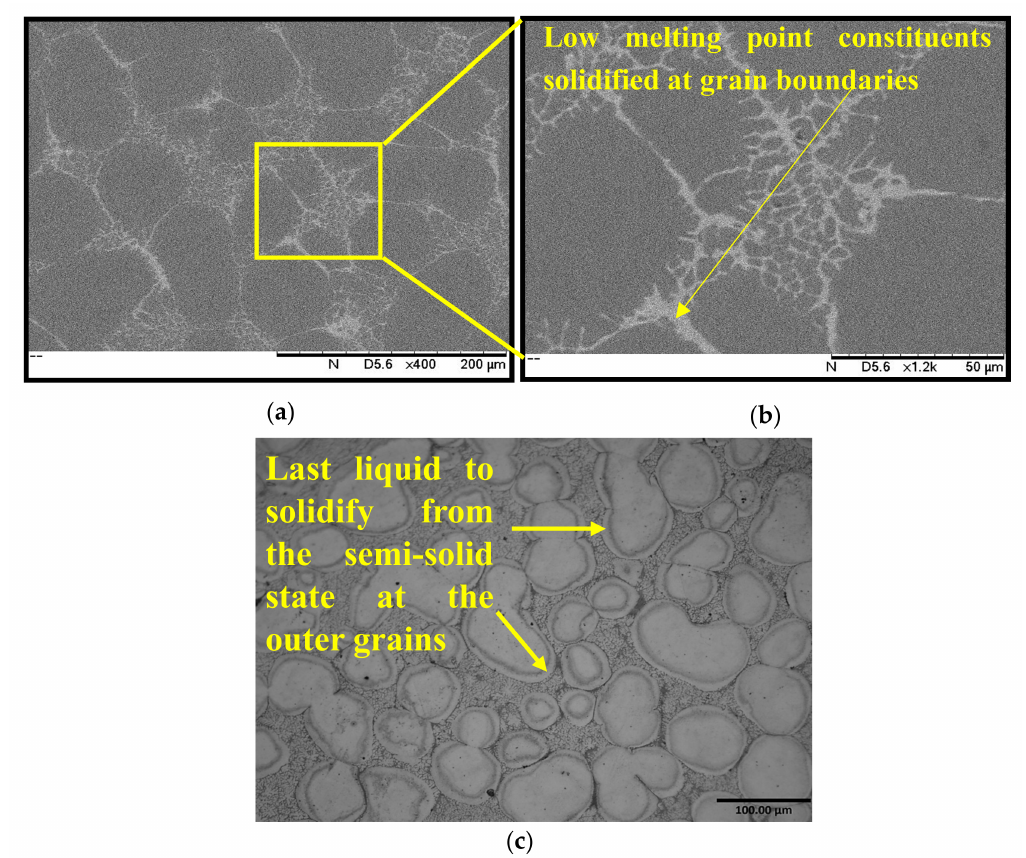
Figure 3. ( a ) Scanning Electron Microscopy image of Al 7075 alloy showing the last liquid phase to solidify at grain boundaries; ( b ) a higher magnification SEM image of the liquid phase; ( c ) optical microscopy image showing the last liquid solidified around the